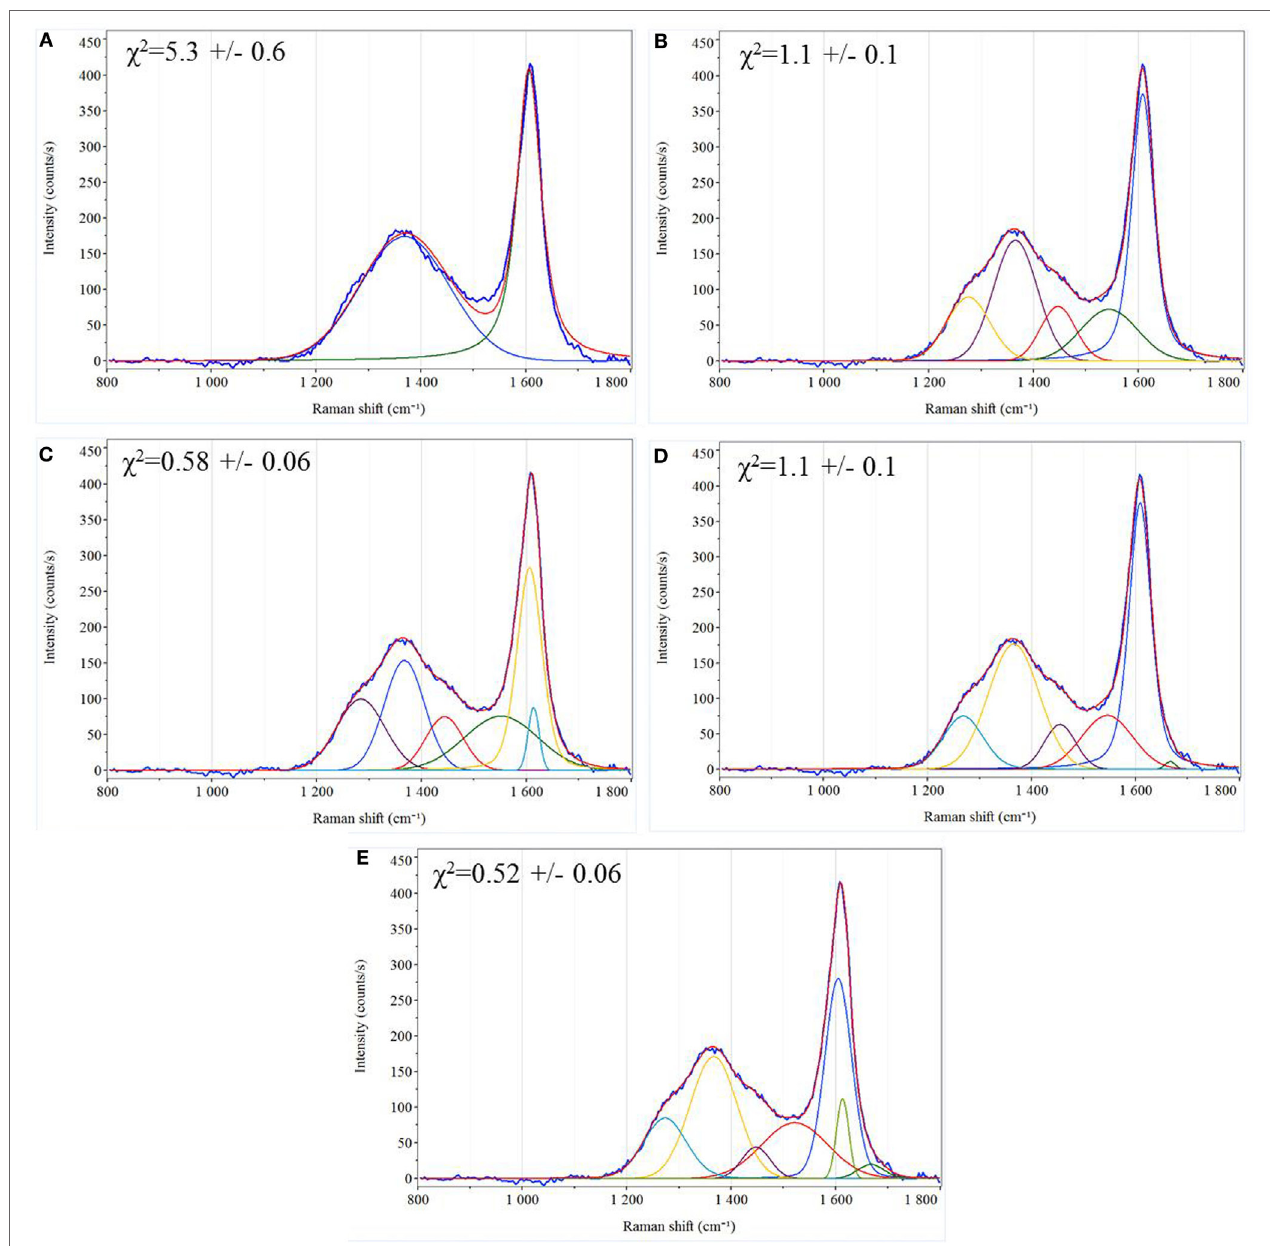
FigUre 3 | Comparison of peak-fitting iterations using (a) two peaks, (b) five peaks, (c) six peaks, with the sixth located ~1,610 cm − 1 , (D) six peaks, with the sixth located ~1,660 cm − 1 , and (e) seven peaks. In each window, the upper, continuous red trace represents the reconstructed Raman spectrum. This trace is overlaid on the original, blue Raman spectrum as shown in Figure 2 . The colored traces below the reconstructed spectrum are the individual bands used in the